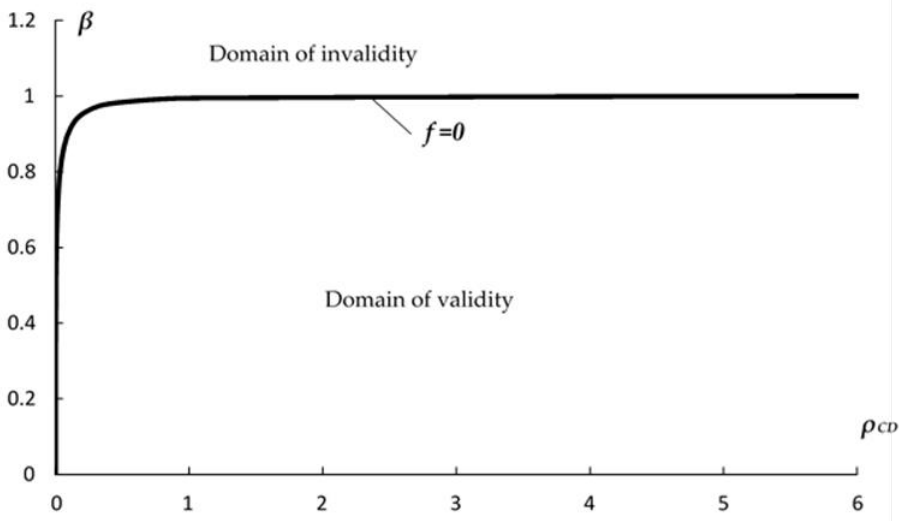
Figure 3. Domains of validity and invalidity of the solution.